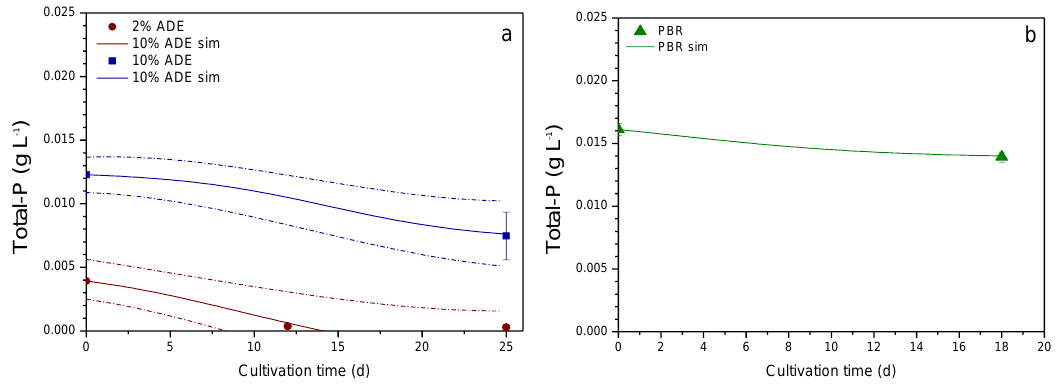
Figure 3. Estimated values of the change in TP concentration as a result of biological removal exclusively by the microalgae P. kessleri in 10% ( v / v ) non-sterilized digested agro-industrial waste and corresponding model simulation, in the case of culture in Erlenmeyer flasks ( a ) and PBR ( b ). Finally, in the case of determining the NH 4 -N concentration in cultures grown in both the Erlenmeyer flasks and the PBR, the model prediction was also very accurate, with R 2 values between 0.83–0.99 (Figure 4 and Table 3). The calculations were carried out considering the percentage composition of P. kessleri biomass in nitrogen (4%), as obtained literature ranging between 2.1–6.3% [40,41]. Parachlorella kessleri has been reported in